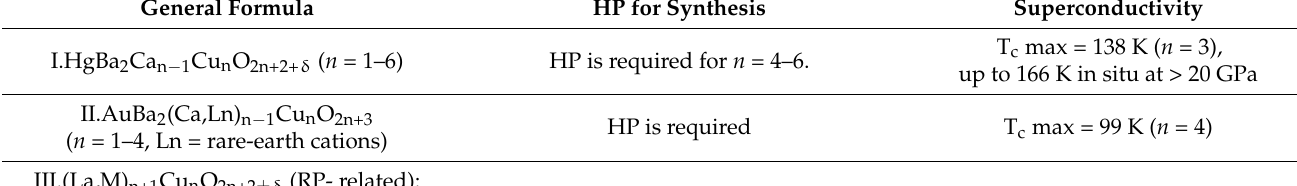
Table 1. Series of cuprates containing structural flat fragments: high-pressure (HP) synthesis and superconductivity. General Formula HP for Synthesis